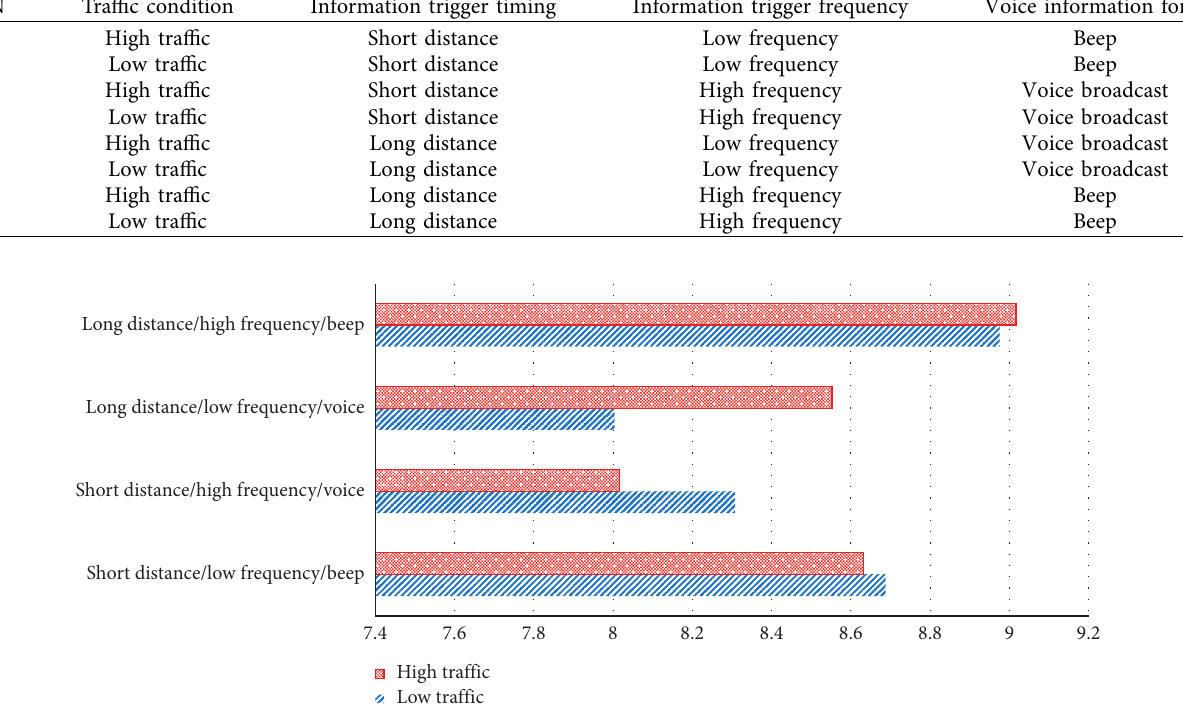
Table 3: Arrangement of test for each subject.